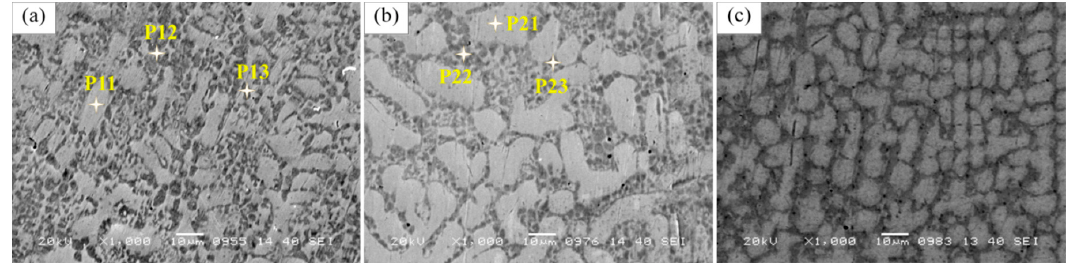
Figure 7. SEM images of the middle region in the second cladding coating: ( a ) sample LC1; ( b ) LC2; ( c ) LC3.